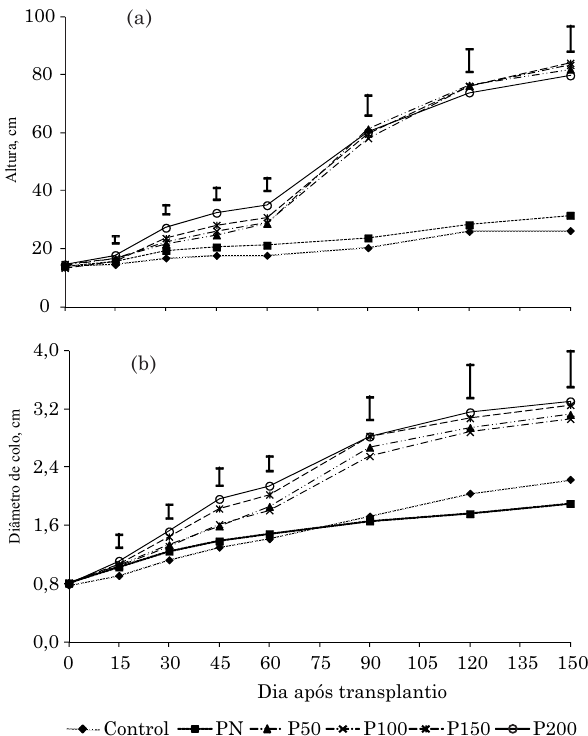
Figura 1. Altura (a) e diâmetro de colo (b) de plantas de pinhão-manso em função de doses de fósforo ao longo de 150 dias após transplantio. Barras verticais indicam o valor de DMS pelo teste Tukey a 5 %.